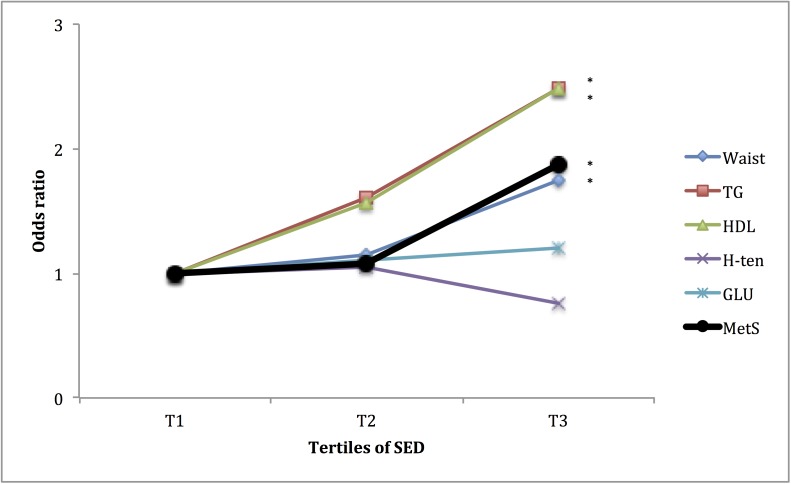
Relationship between tertiles of SED and unfavourable sub-components of METs.ORs are adjusted for gender, age, education level (university degree vs. not), energy intake (kcal·d-1 in quartiles), smoking habits (regular smoker vs. not) and psycho-social stress (self-reported into four levels), % of wear time spent in MVPA (in tertiles), and estimated VO2max (ml·min-1·kg-1, in tertiles). * Denotes significant difference to reference group.